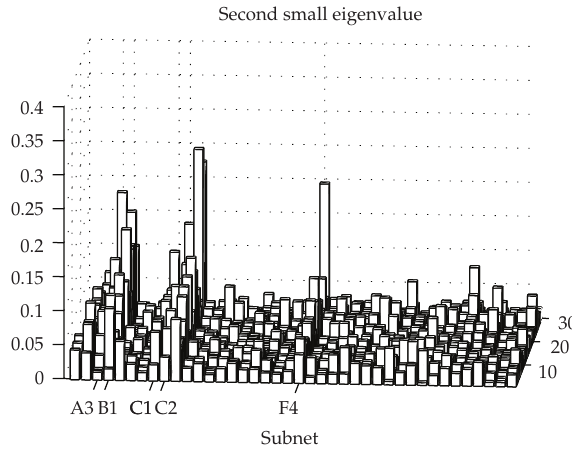
Figure 7: The spectrum of the second small eigenvalue with observation points A3, B1, C1, C2, D1,